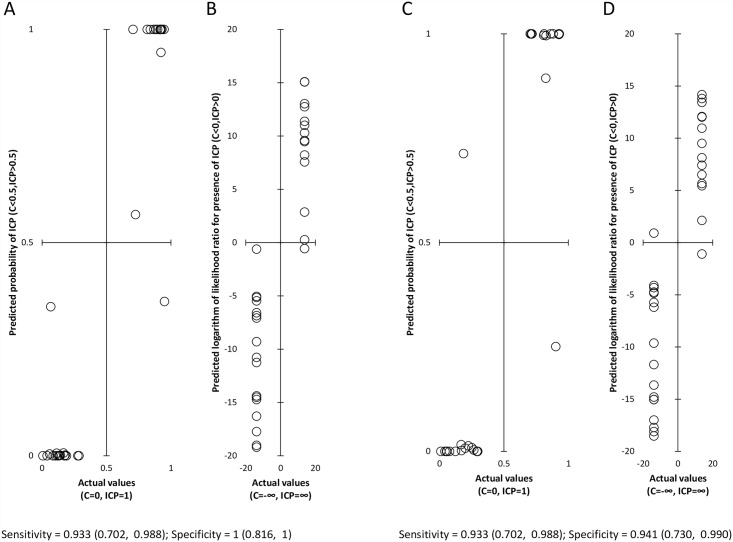
Discrimination of women with intrahepatic cholestasis of pregnancy (ICP) from controls (C) on the basis of maternal circulating steroids measured by radioimmunoassay (17-hydroxypregnenolone sulfate) and GC–MS (remaining steroids) (panels A and B) and on the basis of steroids measured exclusively by GC-MS (panels C and D) using orthogonal projections to latent structures.Panels A and C illustrate the comparison of the probability of pathology with the actual state, while Panels B and D show logarithms of the ratios of the probability that the subject is a patient to the probability that the subject is a control (logarithm of the likelihood ratio, LLR, actual probability of ICP for patients = 1, LLR = ∞, actual probability of ICP for controls = 0, LLR = -∞). A good discrimination using discrimination on the basis of steroids measured by radioimmunoassay and GC–MS (sensitivity of 0.933 (0.702, 0.988) and specificity of 1.000 (0.816, 1.000) (shown as estimates with 95% confidence limits)) as well as for that on the basis of the steroids measured exclusively by GC–MS (sensitivity of 0.933 (0.702, 0.988) and specificity of 0.941 (0.730, 0.990)).